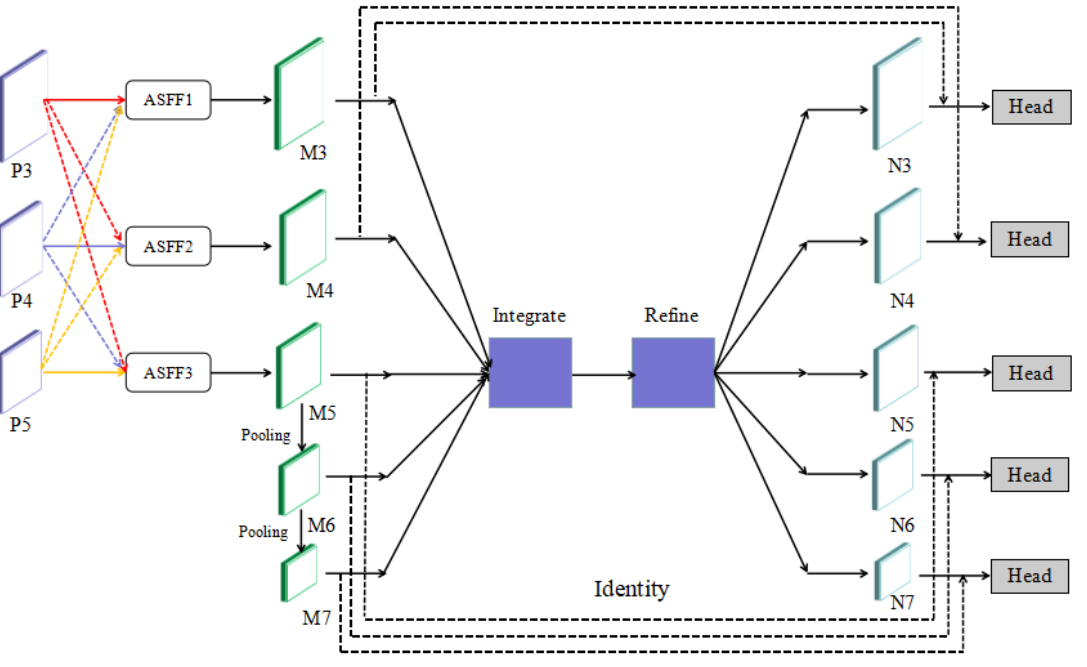
Figure 4. Architecture diagram of Adaptive Feature Equalization